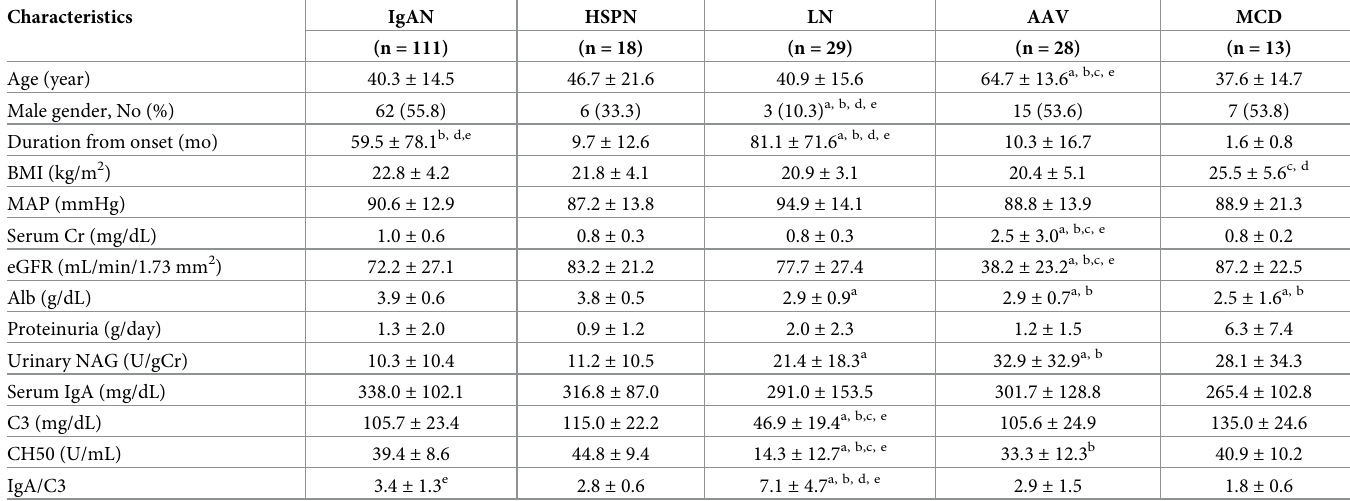
Table 2. Comparison of characteristics among patients with IgAN and other kidney diseases.